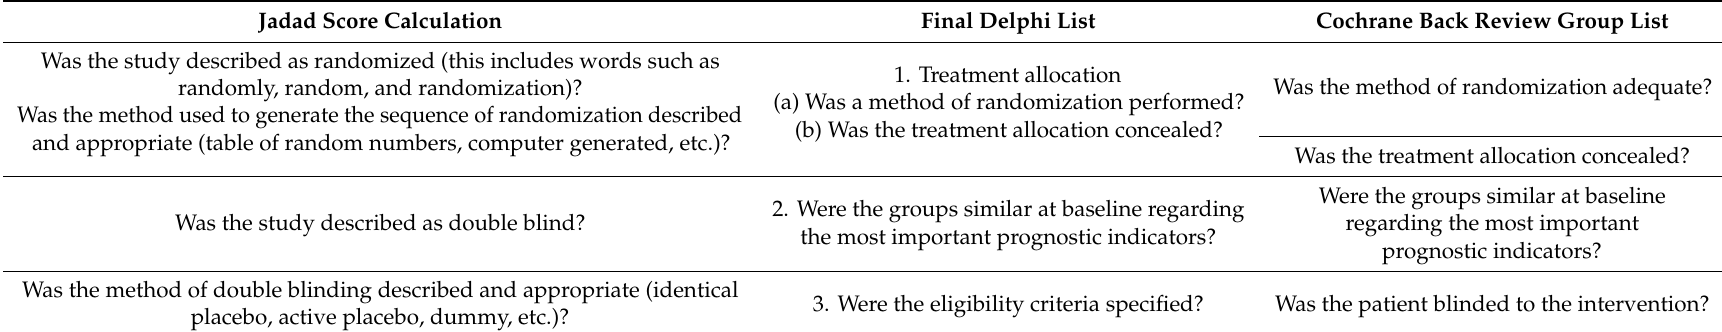
Table 3. Scales for clinical trial evaluation and the items in each